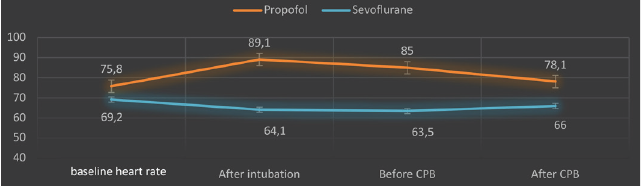
Figure 1 - Heart rate in both groups before and during anaesthesia.